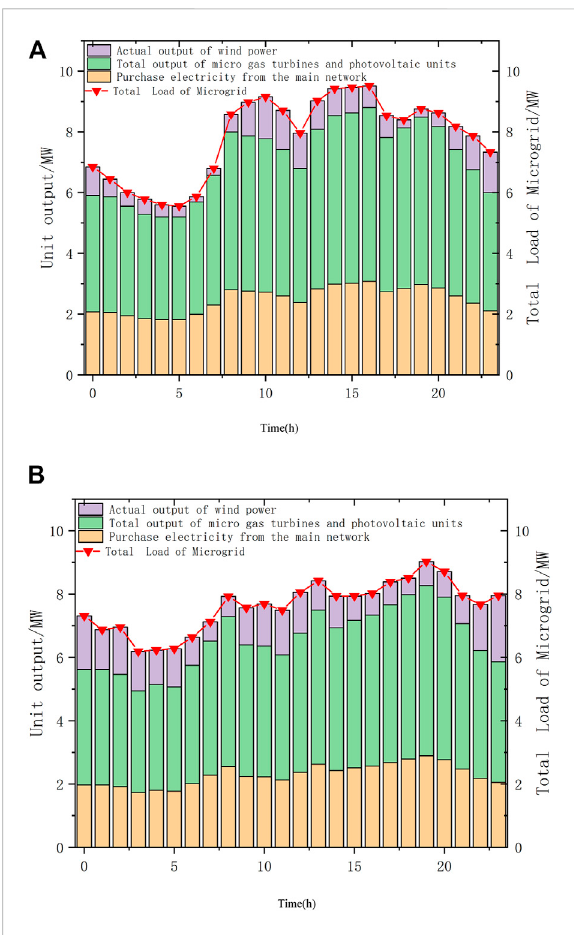
FIGURE 7 (A) 5G base station is not connected to the microgrid. (B) . 5G base station access to